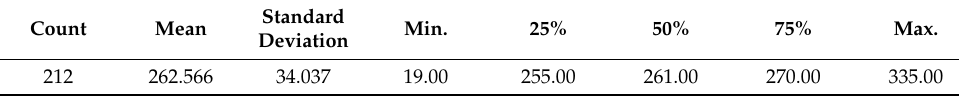
Table 4. ECDC T Variable Per Country Summary